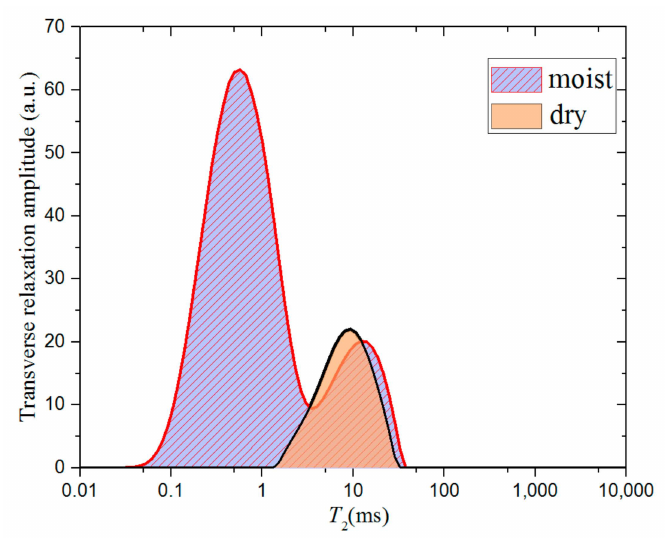
Figure 10. Transverse relaxation amplitude of shale particle sample 1 detected by low-field Nuclear Magnetic Resonance. The T 2 measuring sequence is CPMG.